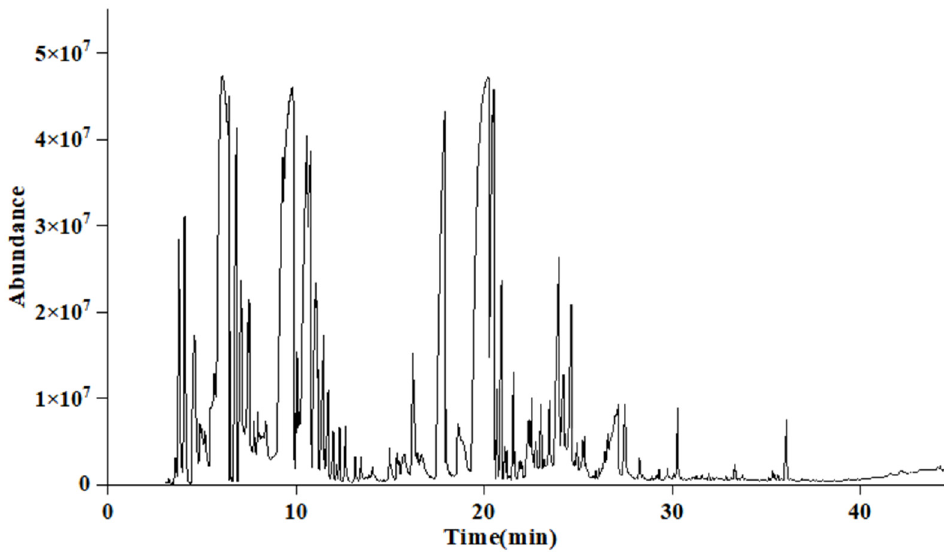
Figure 1. The total ion figure of AgEo. Table 1. The chemical composition of AgEo.